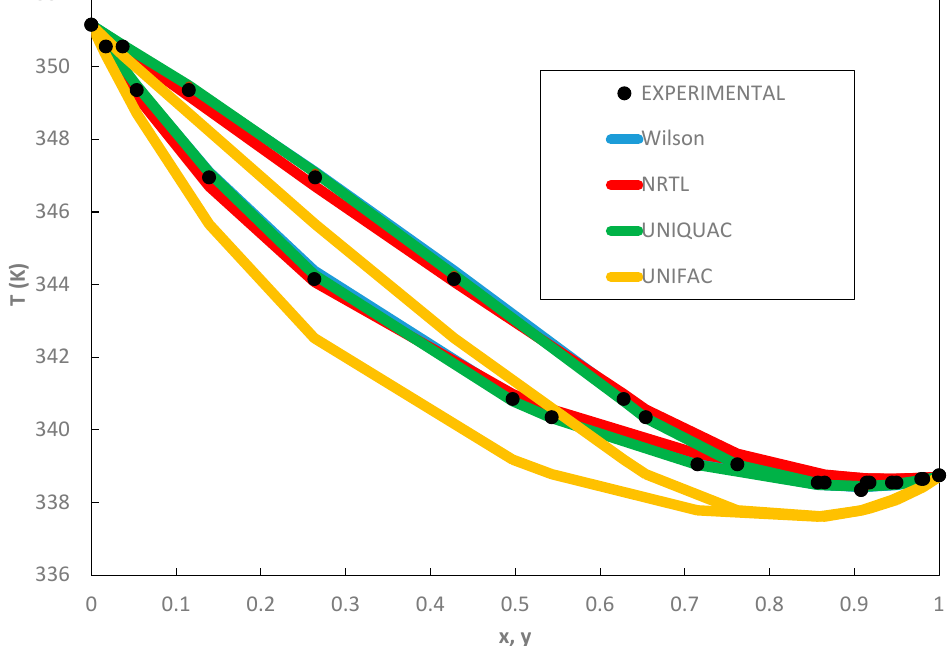
Figure 4. Experimental [15] and predicted T-xy diagram of THF(1) + Ethanol(2) at 100 kPa using Wilson, NRTL, UNIFAC, and UNIQUAC as predictive models.